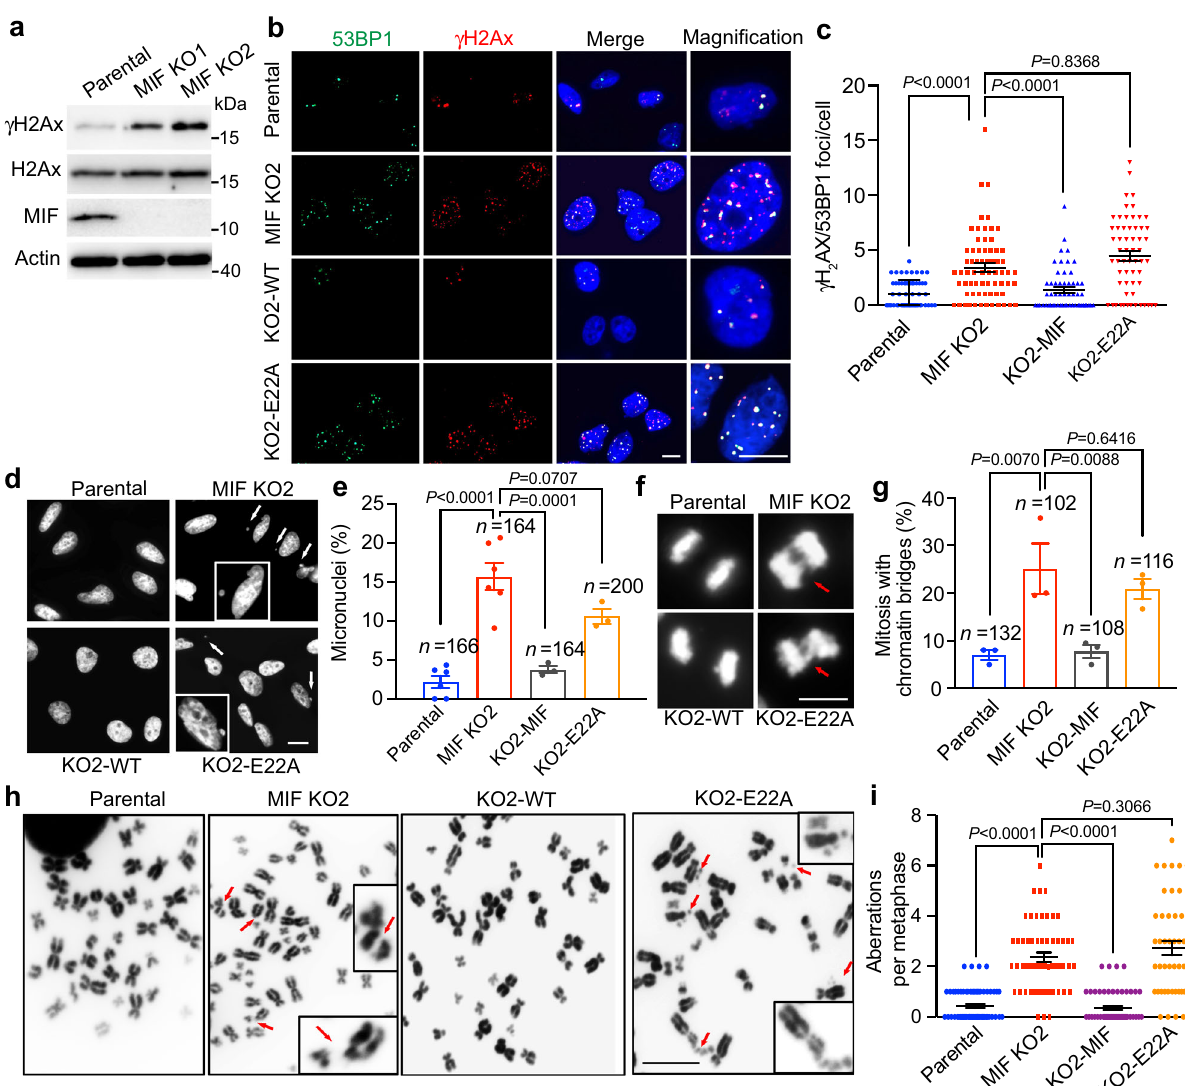
Fig. 6 Loss of MIF and its nuclease activity caused genomic instability. a The basal levels of γ H 2 AX protein in parental and MIF KO MDA-MB-231 cells. Representative blots from three independent experiments are shown. b , c Representative images of γ H 2 AX and 53BP1 foci in parental, MIF-KO2, KO2 + MIF-WT and KO2 + MIF-E22A MDA-MB-231 cells ( b ). Data were quanti fi ed and shown in c (mean ± SEM). Scale bar, 20 μ m. n = 58 cells (parental), n = 67 cells (MIF-KO2), n = 57 cells (KO2-MIF), and n = 59 cells (KO2-E22A) from three independent experiments were analyzed. Statistical signi fi cance was determined by one-way ANOVA Dunnett ’ s multiple comparisons test. d , e Representative images of micronuclei indicated by DAPI staining in parental, MIF-KO2, KO2 + MIF-WT, and KO2 + MIF-E22A MDA-MB-231 cells ( d ). Data were quanti fi ed and shown in e (mean ± SEM). Statistical signi fi cance was determined by one-way ANOVA Dunnett ’ s multiple comparisons test. Scale bar, 20 μ m. f , g Representative images of chromosome bridges indicated by DAPI staining in parental, MIF-KO2, KO2 + MIF-WT and KO2 + MIF-E22A MDA-MB-231 cells ( f ). Data were quanti fi ed and shown in g (mean ± SEM). Statistical signi fi cance was determined by one-way ANOVA Dunnett ’ s multiple comparisons test. Scale bar, 10 μ m. h , i Representative images of metaphase spread assay in parental, MIF-KO2, KO2 + MIF-WT, and KO2 + MIF-E22A MDA-MB-231 cells treated with colchicine for 2 h ( h ). Data were quanti fi ed and shown in i (mean ± SEM). n = 73 cells (parental); n = 56 cells (MIF-KO2); n = 58 cells (KO2 + MIF-WT) and n = 47 cells (KO2 + MIF- E22A) were analyzed from three independent experiments. Statistical signi fi cance was determined by one-way ANOVA Dunnett ’ s multiple comparisons test. Scale bar, 10 μ